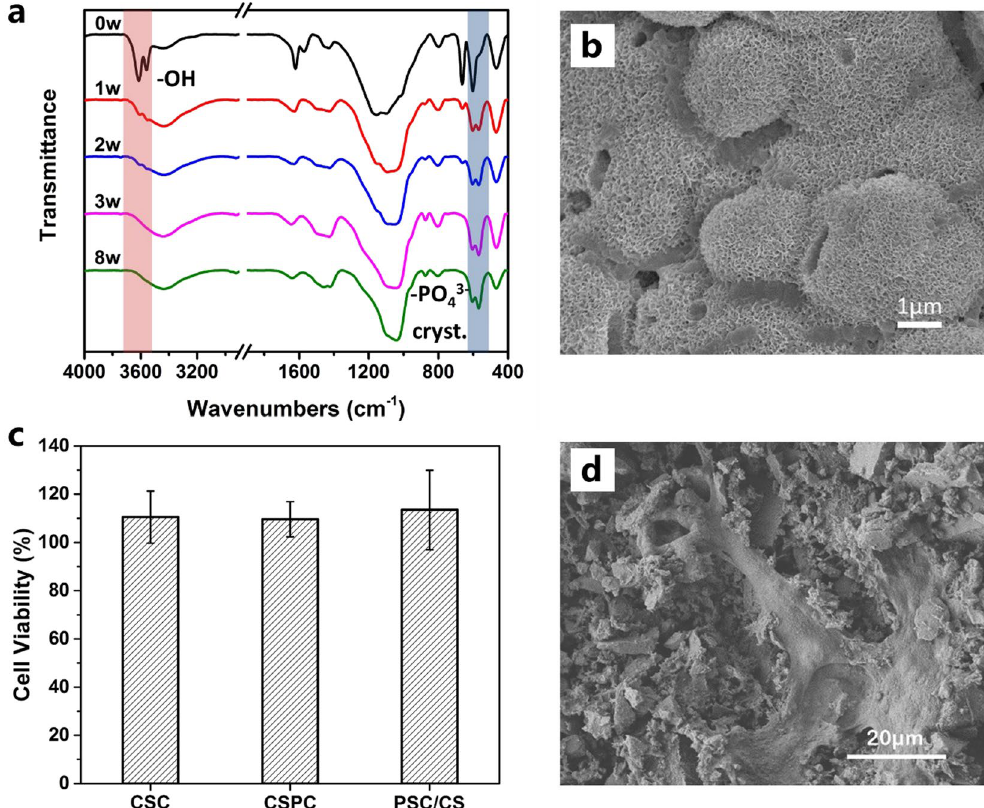
Figure 2. ( a ) FTIR spectra of the PSC/CS cement after immersion in SBF for 0, 1, 2, 3 and 8 weeks. ( b ) SEM images of PSC/CS cement after immersion in SBF for 8 weeks. ( c ) MTT assay for proliferation of MG63 cells after culturing for 48 h. ( d ) The MG63 cell morphologies on PSC/CS cement after culturing for 24